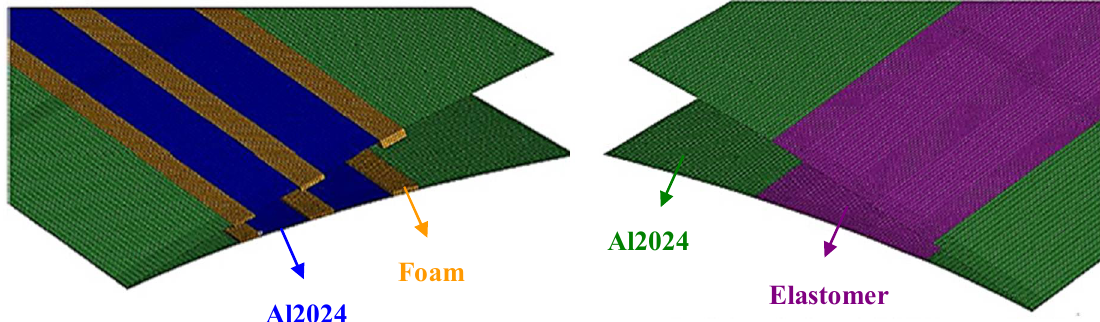
Figure 17. FEM details: skin modelling.